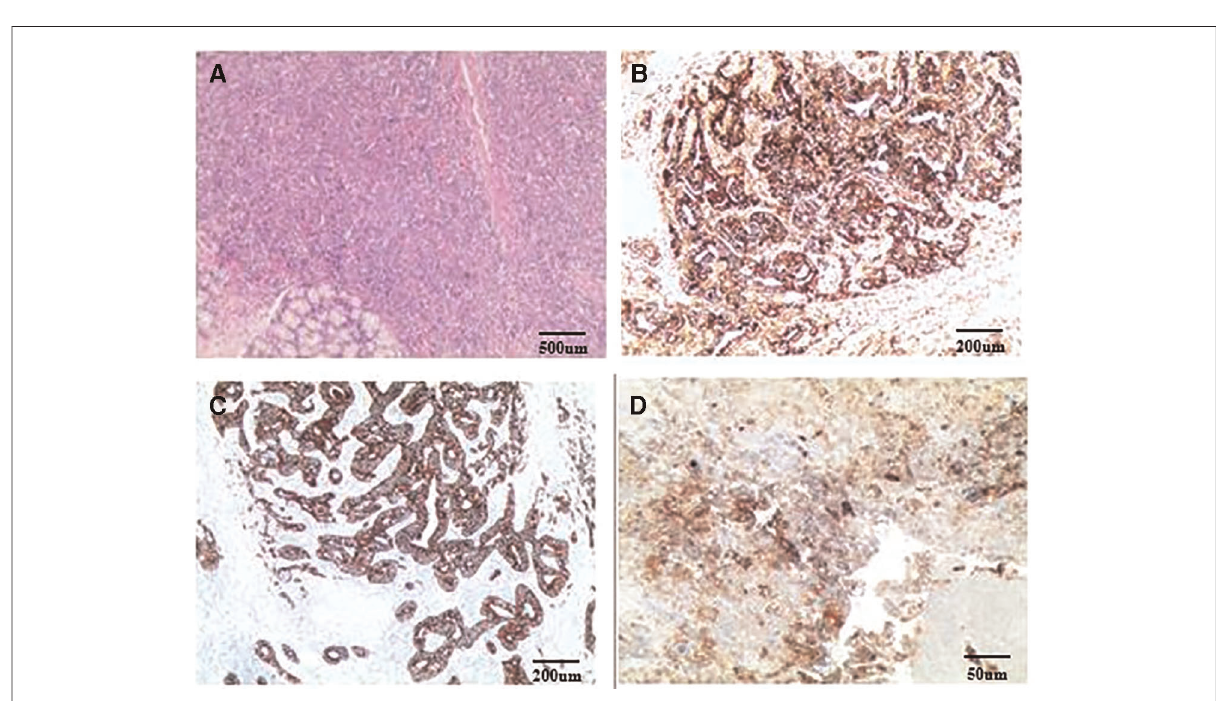
FIGURE 3 Postoperative pathology: ( A ) HE staining; ( B ) AFP staining; ( C ) CK staining; ( D ) PD-L1 staining. Routine pathology: (Stomach) Moderately to poorly differentiated adenocarcinoma, focal features of hepatoid adenocarcinoma, small necrosis, tumor invasion, tumor thrombus in the vessel; (Right liver nodule S5) cancer metastasis; (Left lateral liver) cancer metastasis, with massive necrosis, bleeding, no cancer accumulation in the liver resection margin, while the liver lesions were about 10% of hepatoid adenocarcinoma and 90% were choriocarcinoma. Immunopathology: (Stomach): CK(+), AFP(+), Glypican-3(+), MSH2(+), MSH6(+), MLH1(+), PMS2(+), MSS, Her-2(1+), Ki-67(+, 95%), PD-L1(22C3) (tumor cell: 1% – 5%; microenvironment immune cells: +, 20% – 30%), CD117(+), Hepa-1( − ), CK7( − ), CK5/6( − ), P40( − ), PD-1( − ), CD5( − ), Vimentin( − ), EVB( − ); (Liver): CK7 (+), Her-2(2+), Ki67(+, 95%), PD-L1(22C3)(+, >50%), MLH1(+), MSH2(+), MSH6(+), PMS2(+), MSS, AFP( − ), Hepa-1( − ), CD5( − ), and EBV( −